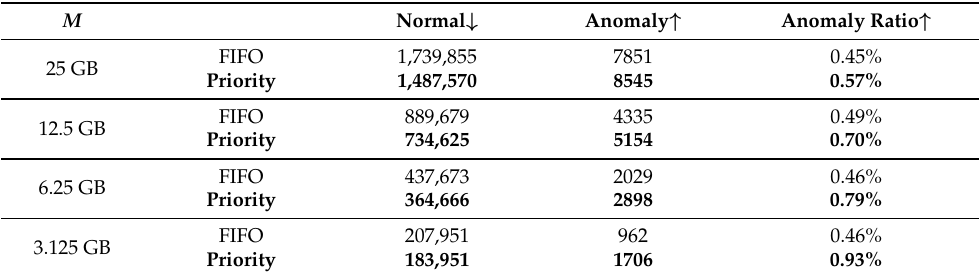
Table 6. Comparison of prioritized recording and